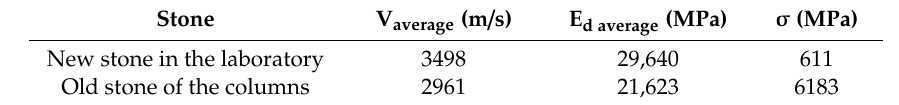
Table 3. Ultrasonic tests on new and old stones.